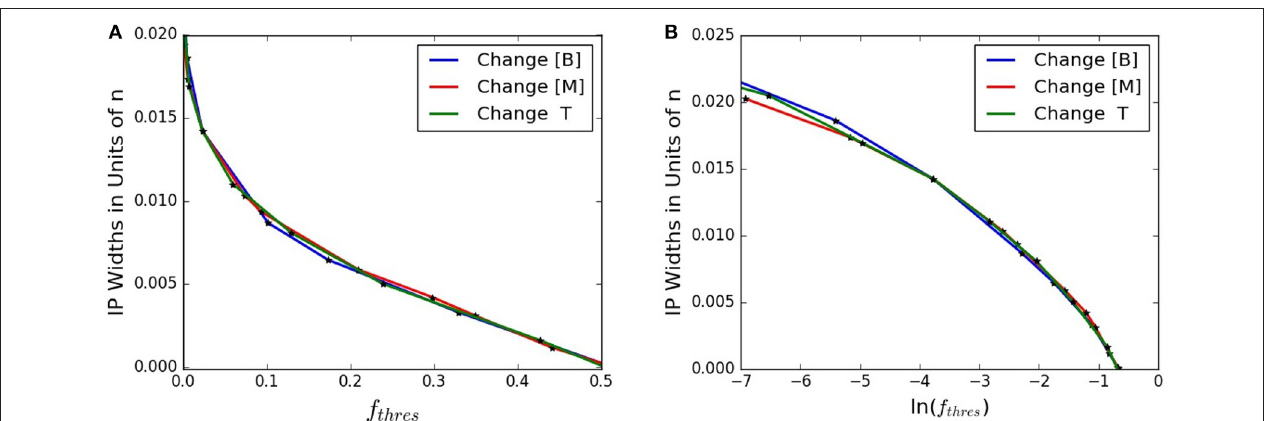
FIGURE 5 | (A) The IP width, w n , given by Equation (8), based on f thres . (B) The IP width, w n , given by Equation (8), based on ln( f thres ).